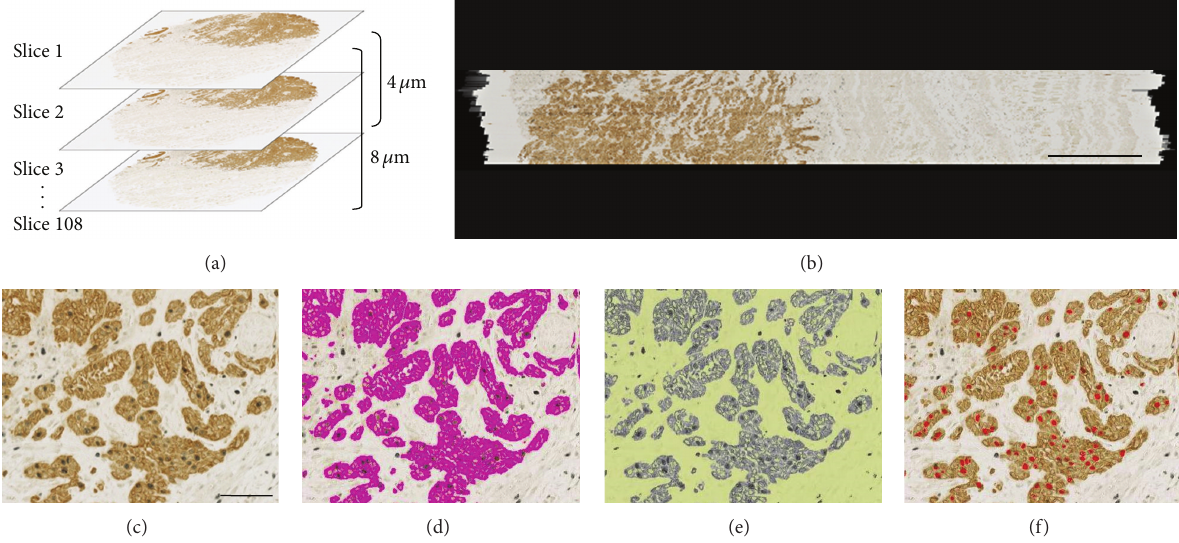
Figure 2: (a) Image registration of consecutive histological images in the 𝑧 -axis. (b) Sagittal cross-cut view through the center of an image stackcomprising108serialsections,showingsuccessfulsuperimpositionwithoutmarkedirregularityordistortionininteriortissuegeometry. Bar = 0.5 mm. ((c)–(e)) Segmentation of cancer cells and Ki67-positive nuclei: (c) original double-immunostained image with DAB and Vector SG as chromogens; (d) segmentation of CK-positive cancer cell cytoplasm, shown as purple pseudocolor (note that Ki67-negative nuclei remained open within the segmented cytoplasm); and (e) stromal region (yellow) after subtraction of the tumor parenchyma (see text for details); (f) Ki67-positive nuclei (red) attained by ImageJ SG color segmentation. Bar = 50 𝜇